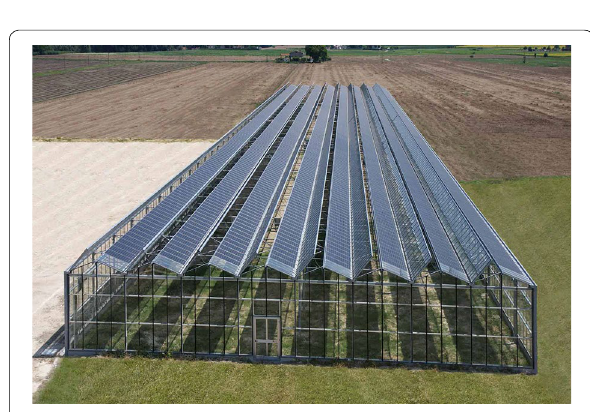
Fig. 5 Photovoltaic tower in Recanati (Source: Blogo)